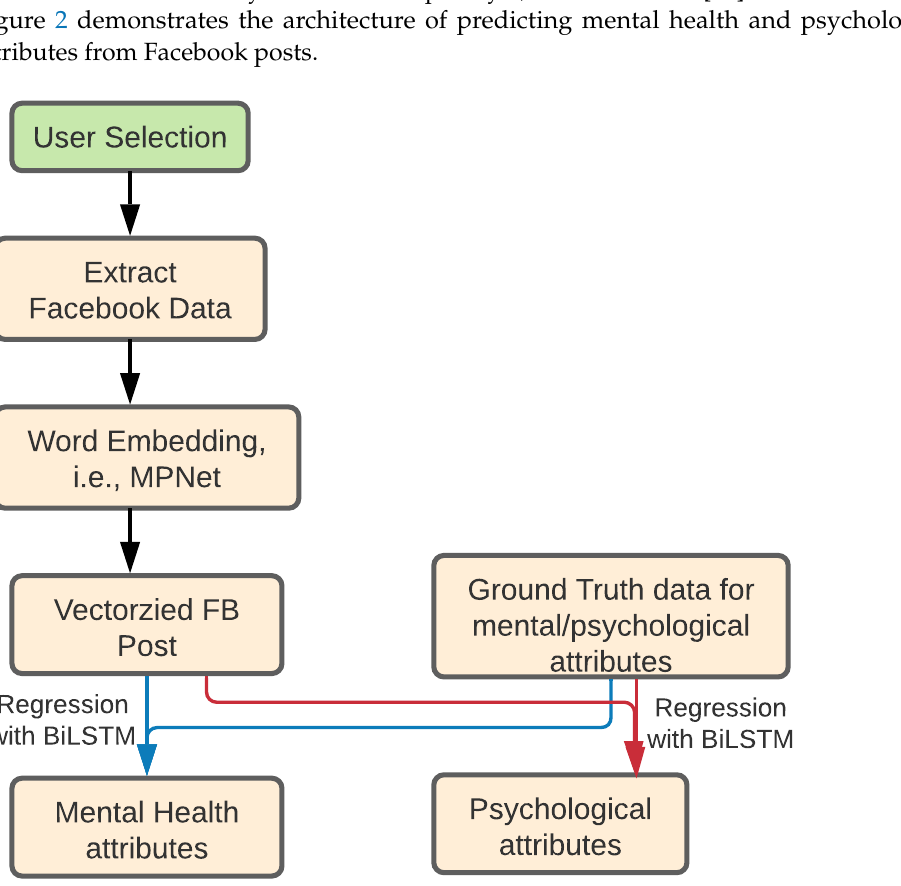
Figure 2. Architecture of predicting mental health and psychological attributes ( SM-MP ) from Face- book